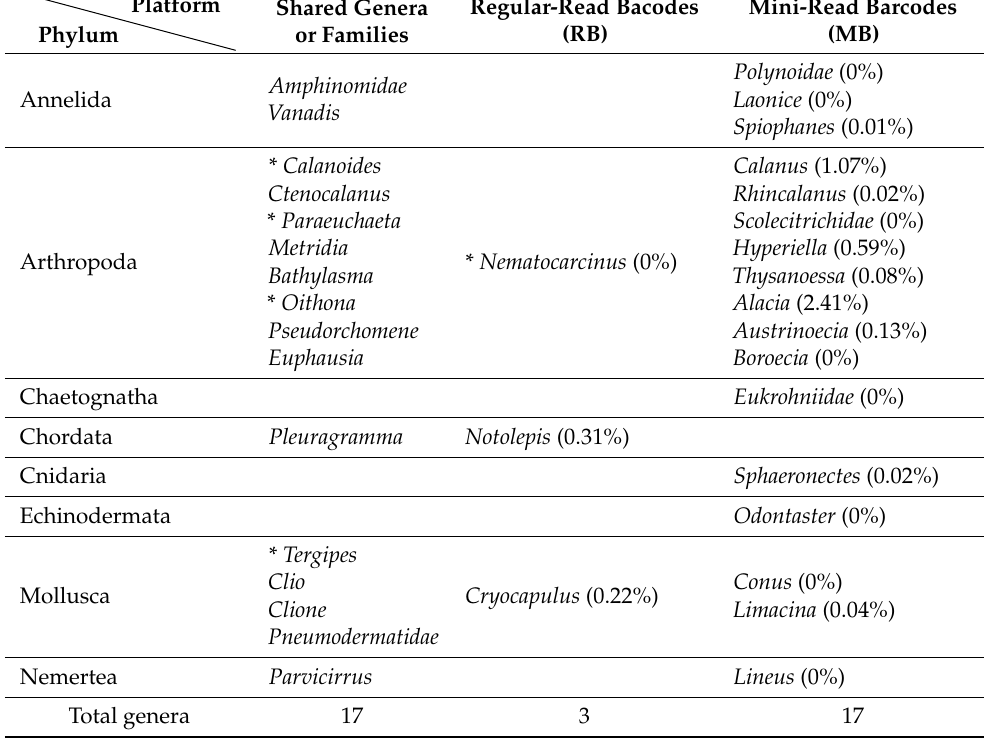
Table 3. Comparison of genera or families obtained by two metabarcoding